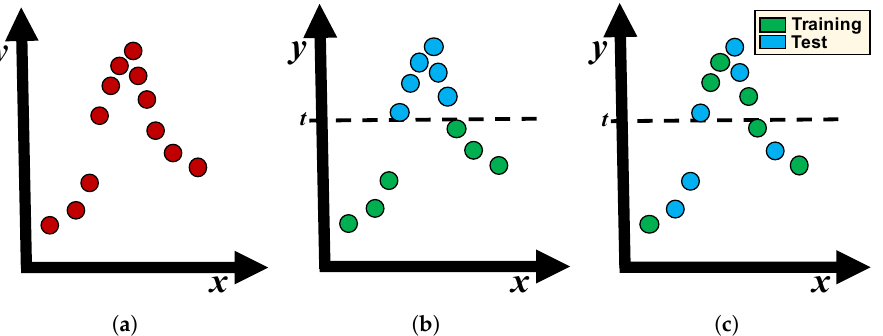
Figure 1. Examples of target shift in a regression dataset. ( a ) Original dataset. ( b ) High target shift. ( c ) Moderate target